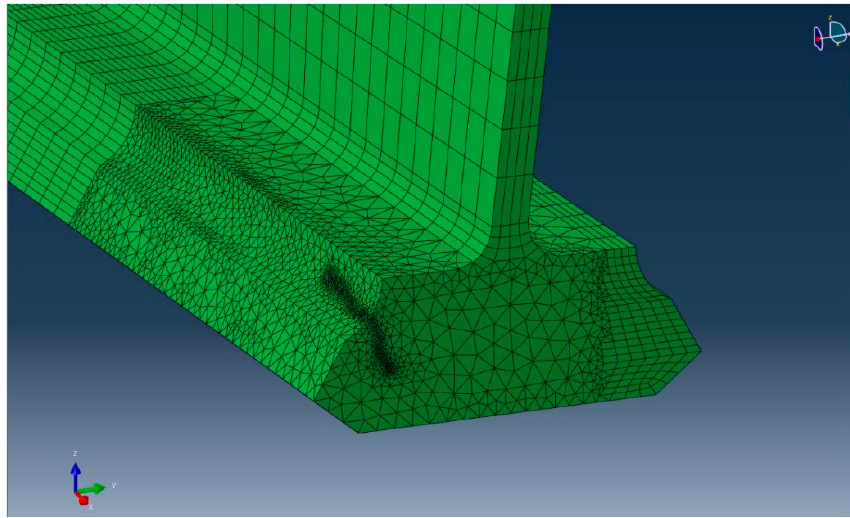
Figure 5. Sub-model containing the crack. The mesh is automatically generated within Franc3D at each iteration.